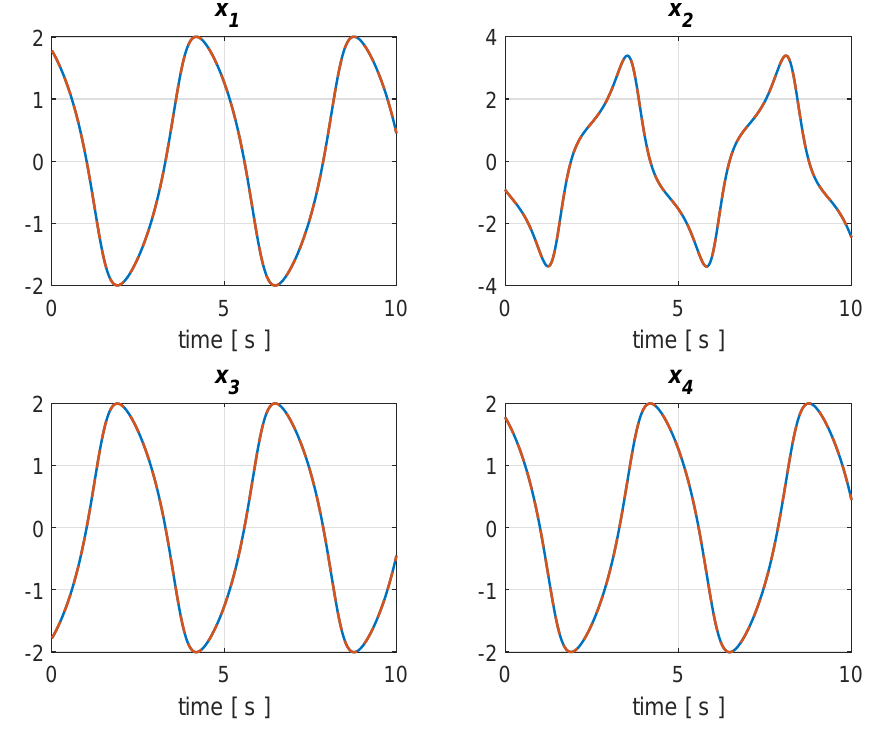
Figure 3. Simulation run at regime without noises and with x ( 0 ) = ˆ x ( 0 ) = ( 1.7809, − 0.9185, − 1.7809,1.7809 ) , where the state variables are in blue and their estimates are in dashed